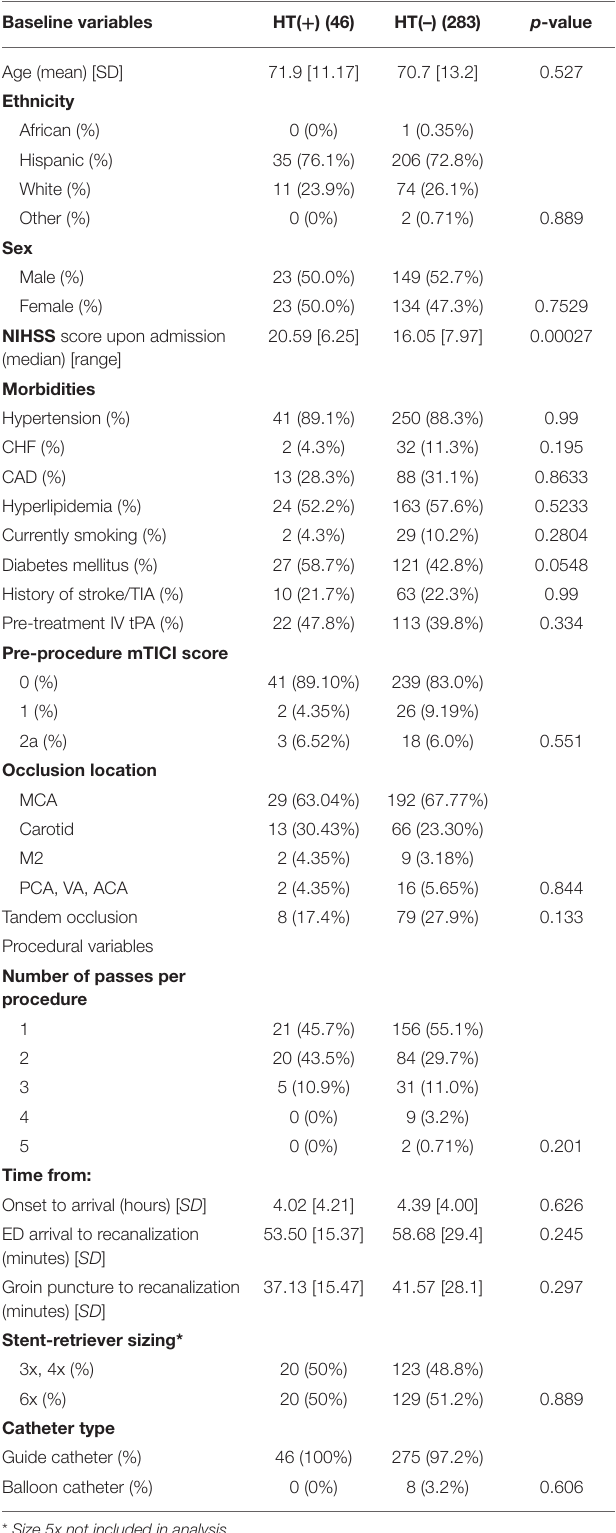
TABLE 1 | Results from the univariate statistical analyses performed on baseline variables and endovascular procedural variables between HT( + ) and HT(–)